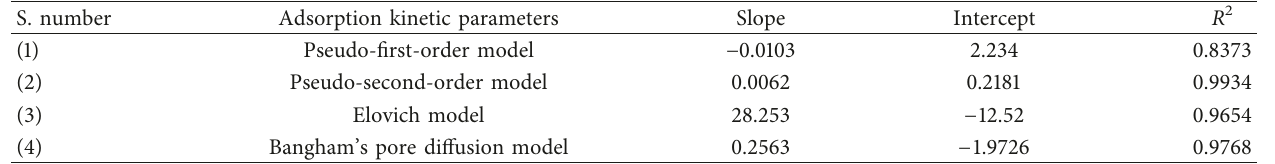
Table 4: Adsorption kinetic